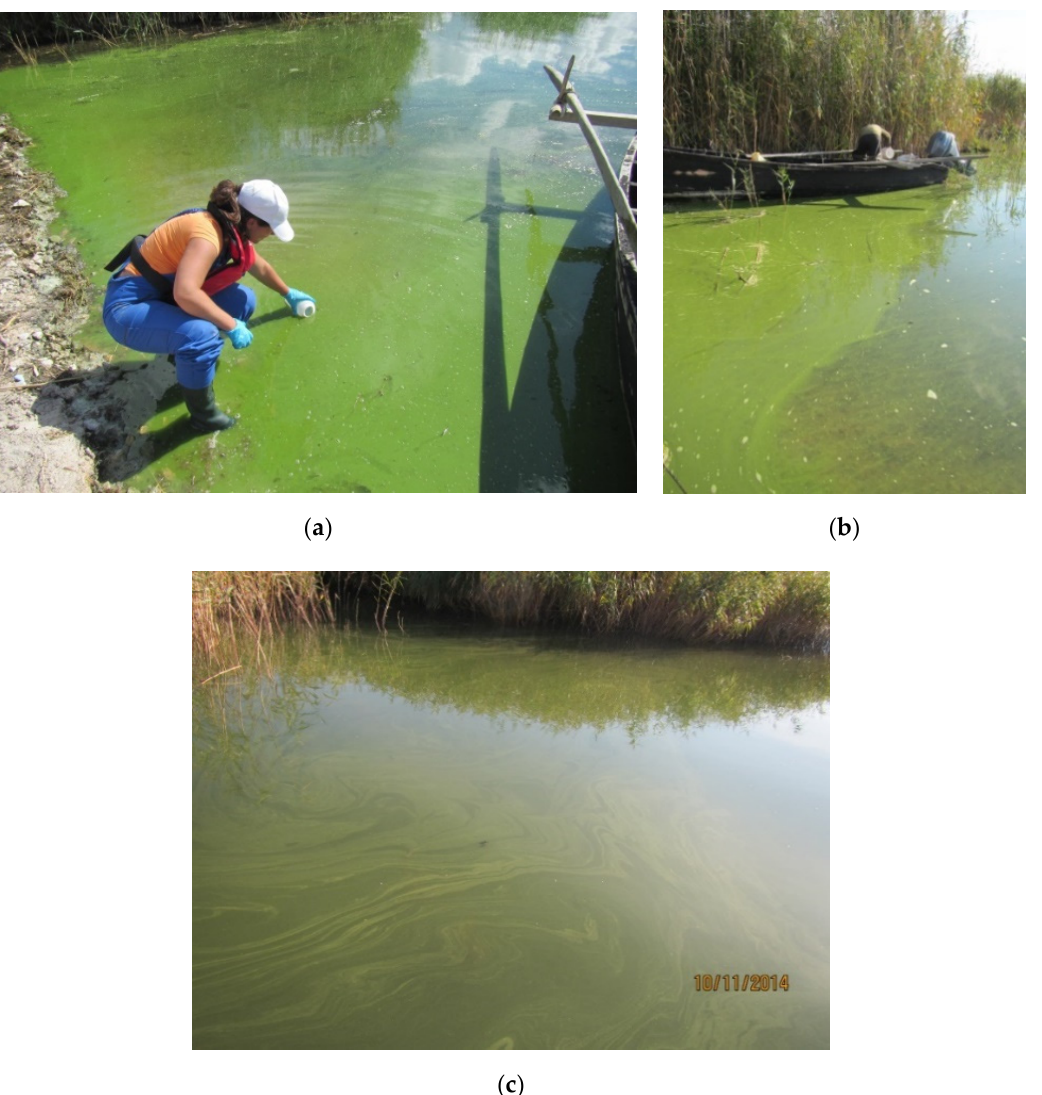
Figure A1. Photos showing the accumulation of surface cyanobacteria scums at the lakeshores of Lesser Prespa in 2014; site II on 4 September 2014 (Panel a ) and 30 October 2014 (Panel b ) and at site III on 10 November 2014 (Panel c ) at Lake Lesser Prespa.